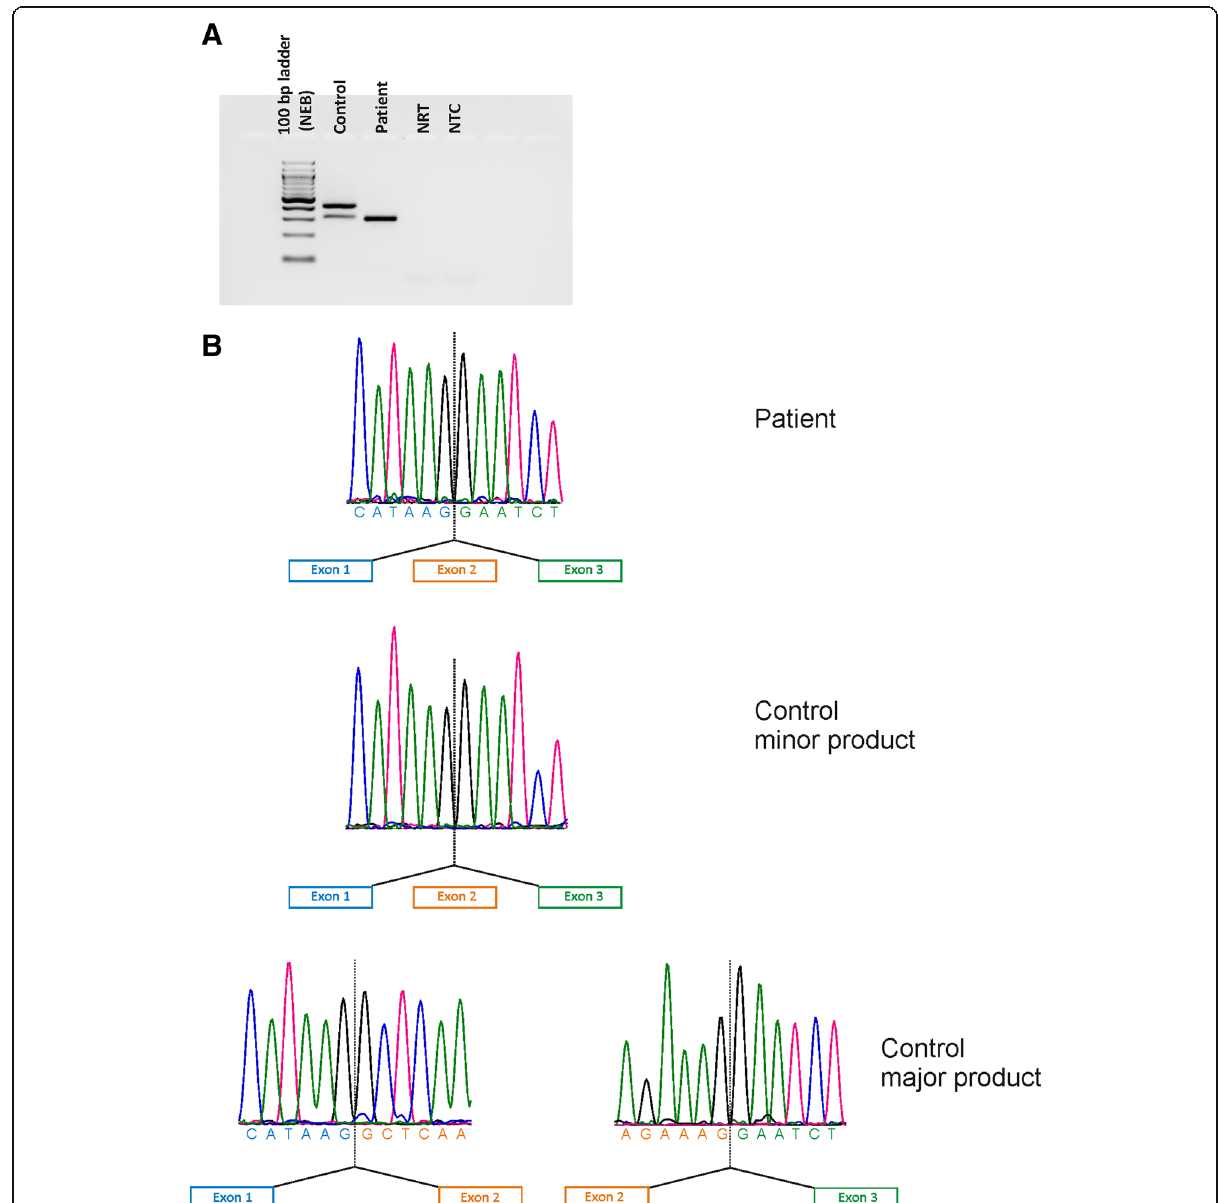
Fig. 5 cDNA analysis of the c.86 + 2 T > C variant. a RT-PCR of an unrelated control subject (lane 2) using a forward primer located in exon 1 and a reverse primer in exon 4 revealed an abundant product of 382 bp corresponding to the major isoform of TMEM126A . In addition, a weak product could be identified, which stems from a minor isoform that lacks exon 2. The RT-PCR of the affected proband in family A (II:1) shows that only the minor isoform is present (lane 3). b Sequencing shows skipping of exon 2 in the single RT-PCR product of the affected proband (upper lane) and for the minor RT-PCR product of an unrelated control subject (middle lane) while correct splicing is observed for the abundant